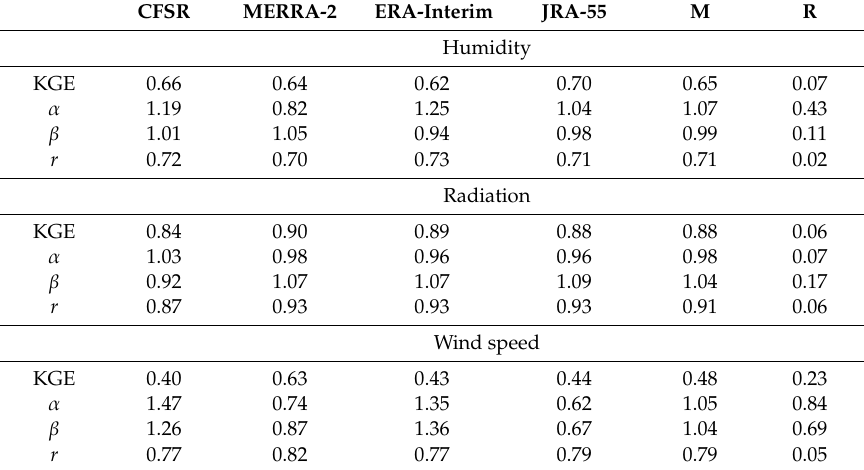
Table 3. Meteorological performance of CFSR, MERRA-2, ERA-Interim and JRA-55 simulating humidity, radiation and wind speed observations. Performance is expressed through the Kling-Gupta e ffi ciency metric (KGE) and its related component ( α , β and r ) evaluated from June to